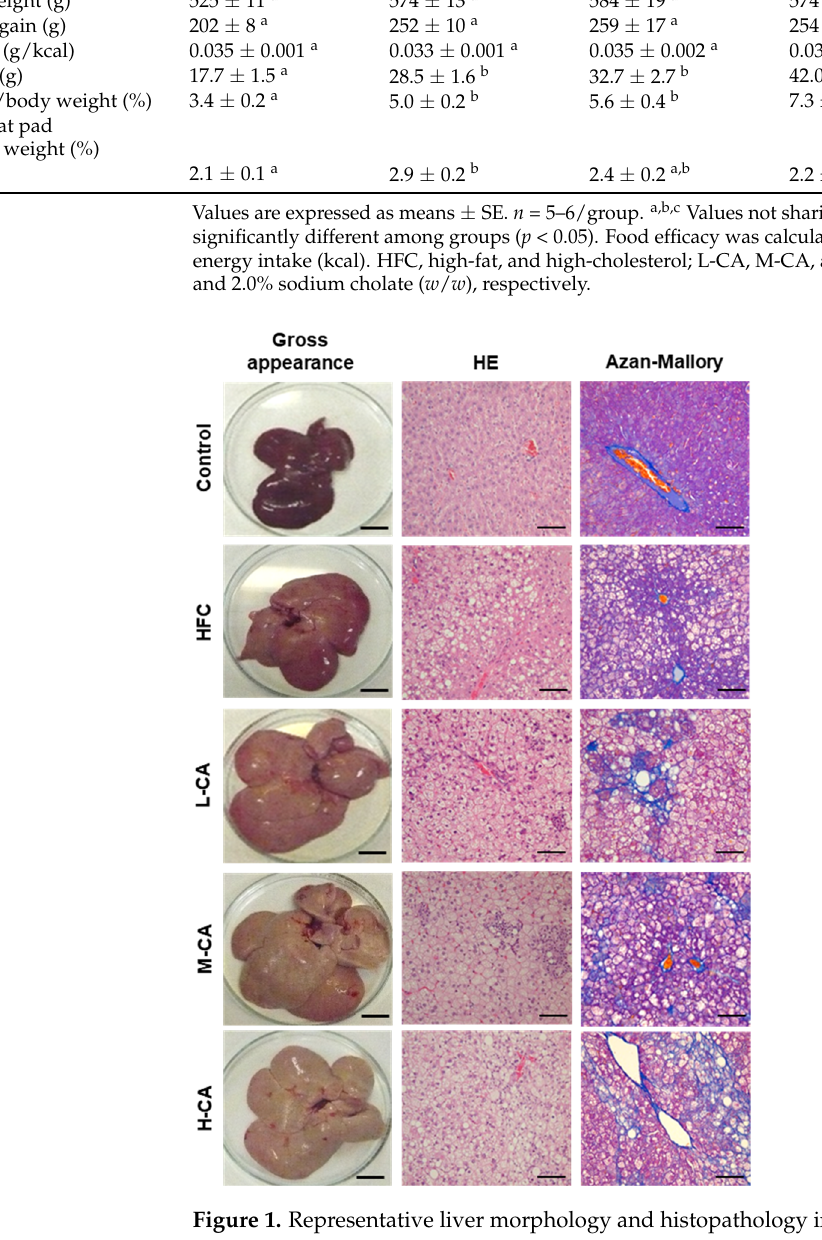
3 of 12 Table 1. Cumulative energy intake, body weight, and relative organ weights in Sprague–Dawley